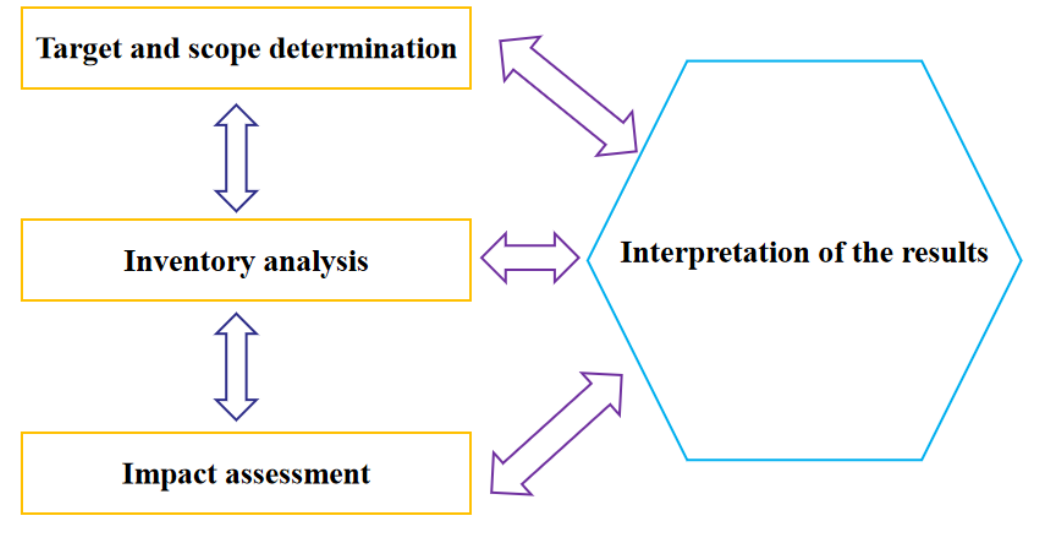
Figure 3. LCA technical framework.